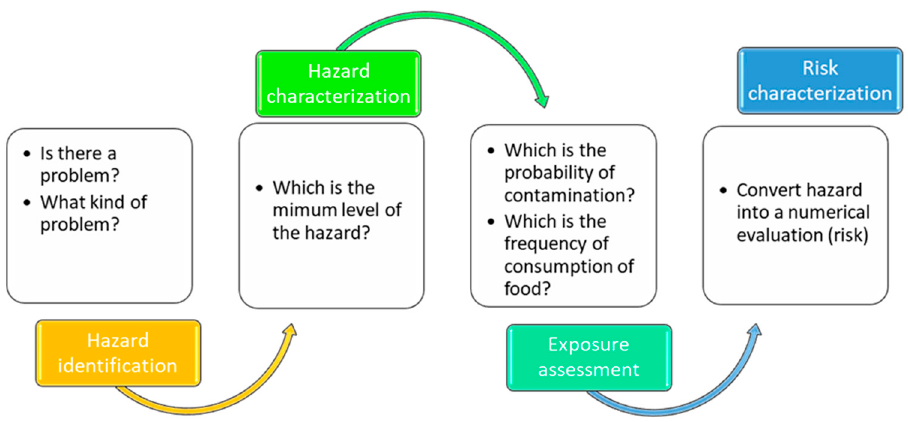
Figure 1. Graphical representation of the top-down ( a ), and bottom-up ( b ) approaches.